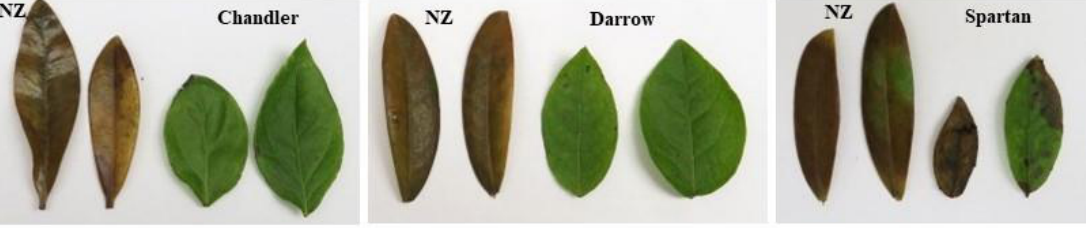
Figure 5. Re-isolation of P. cinnamomi from the substrate on the leaves of rhododendron ‘Nova Zembla’ (left) and highbush blueberry (right), after 5 days.